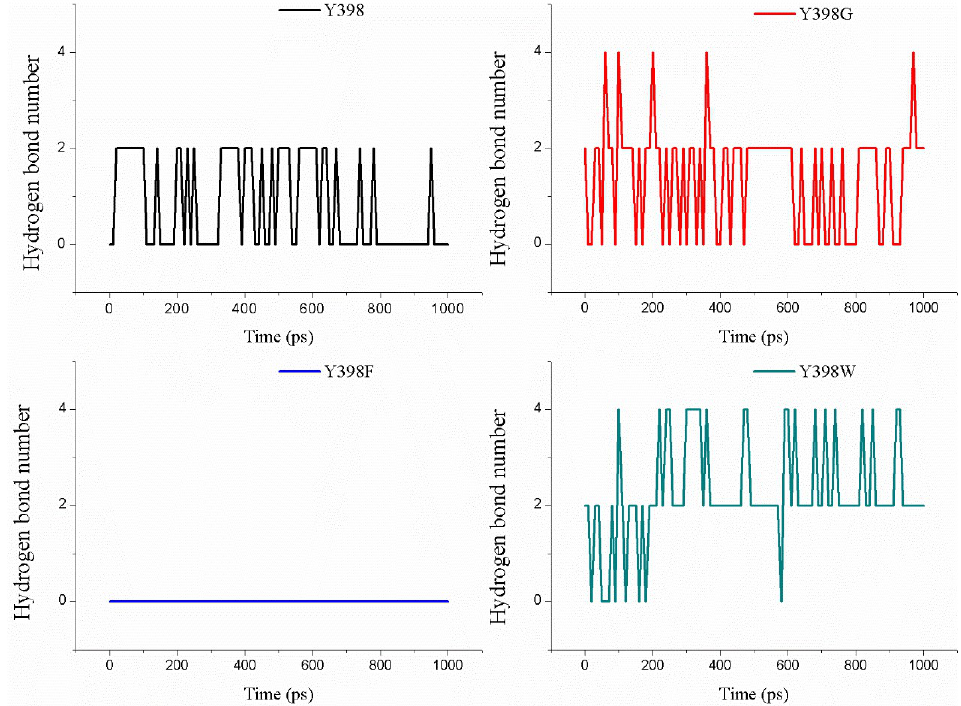
Figure 8. The amount of hydrogen bonds present between ATChI and the ezyme or its mutants during the pulling of ATChI for 1 ns.